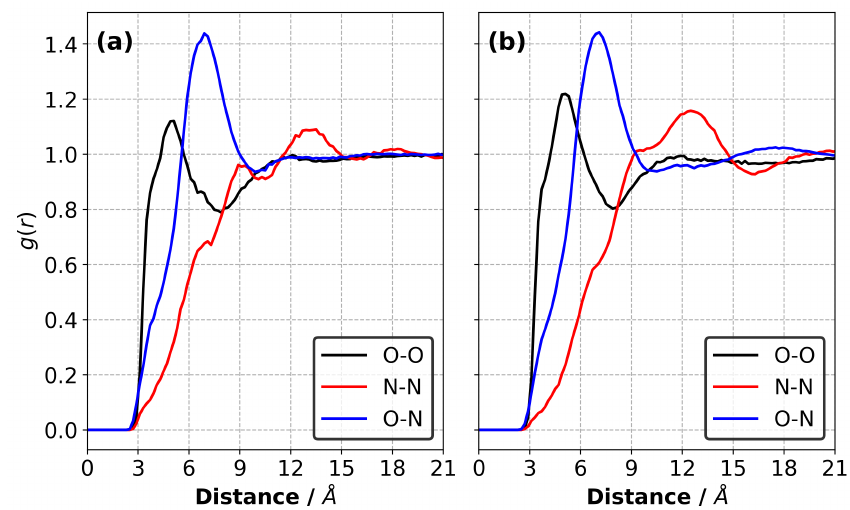
Figure 3. Radial distribution functions (RDFs) between the monomers (the reactive oxygen atom was chosen as a representative atomic site) and anions (the nitrogen atom of the Tf 2 N − was chosen as a representative atomic site) in the liquid ( a ) CEIL-2 and ( b ) CEIL-3 systems at 227 ◦ C.